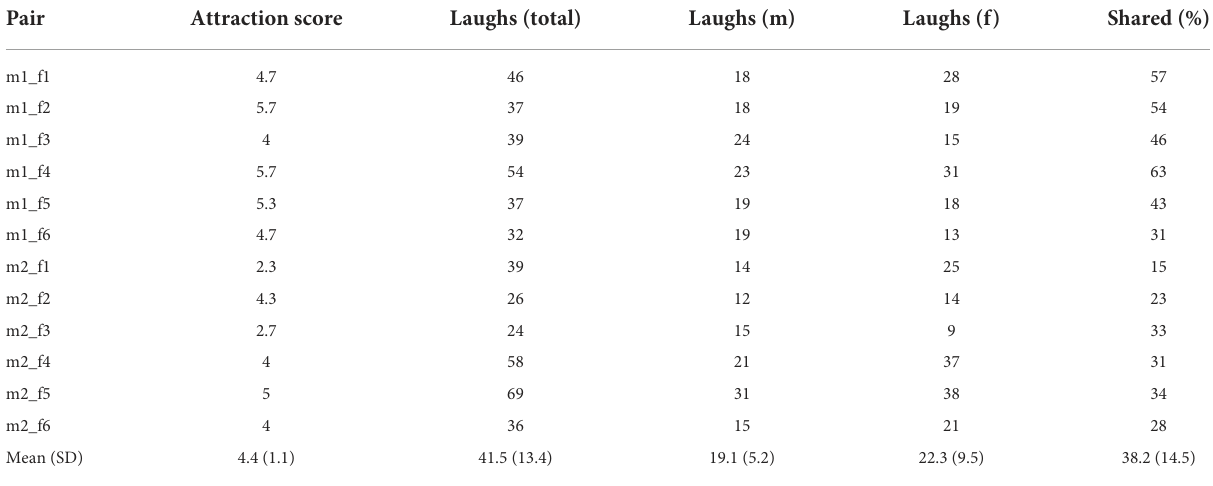
TABLE 1 An overview of the distribution of laughter across the 12 dating pairs (m, male; f, female). Pair Attraction score Laughs